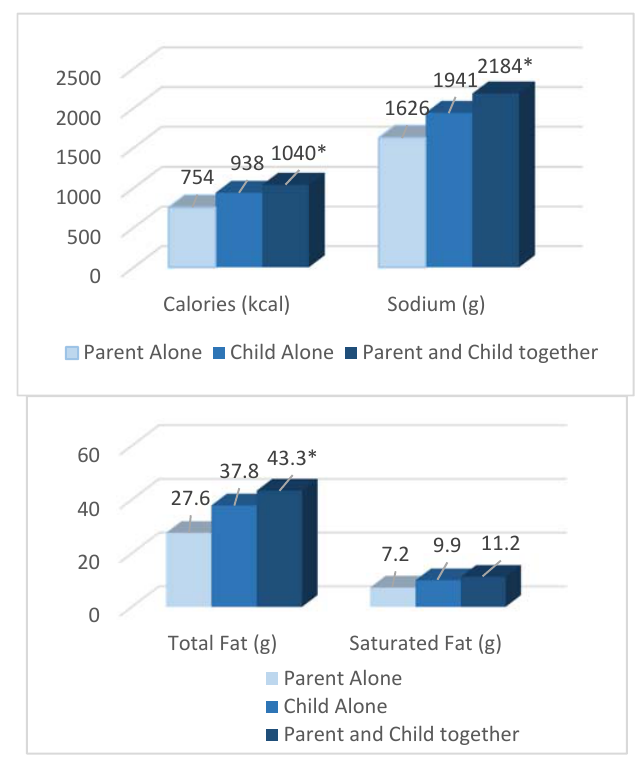
Figure 2. Selection of nutrients from the overall meal by who made the ordering decision (parent alone, child alone, or child and parent together). * Significantly different ( p < 0.05) by who made the ordering decision (parent alone (reference group), child alone, or child and parent together) using mixed ‐ model analysis of variance with restaurant location as a random effect and adjusting for QSR chain, child age, child sex, child ethnicity, parent sex. Values were calculated using least squares mean regression.